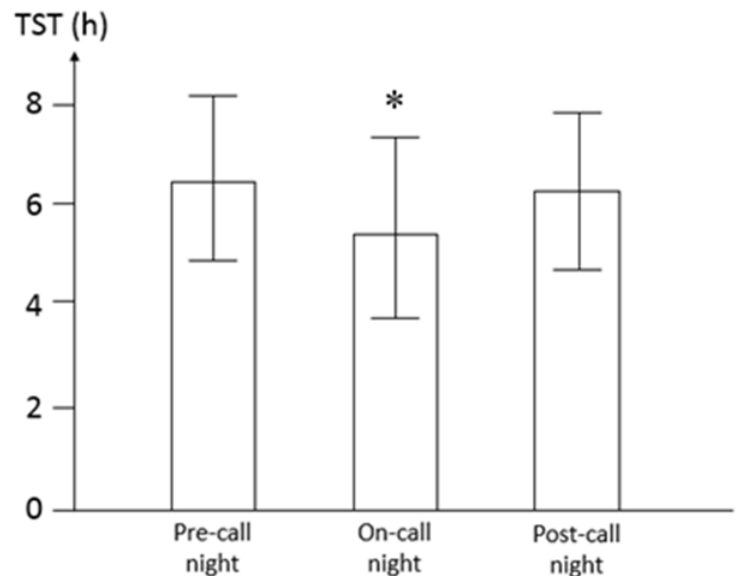
Figure 2. Total sleep time (TST) during the on-call duty cycle. The results are expressed as Mean ± SD. * Residents slept significantly shorter ( p = 0.015) during on-call duty compared to the pre-call night and post-call night by one-way analysis of variance (ANOVA) test.